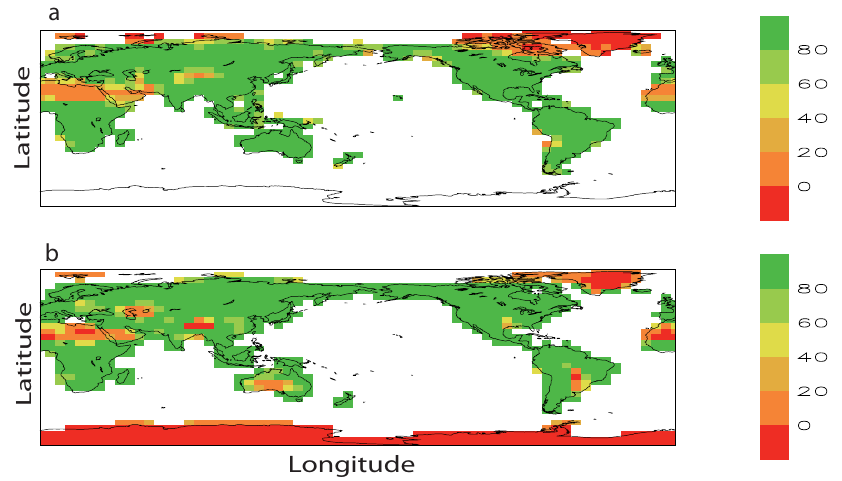
Fig. 14. Total vegetation cover in (a) GSWP2 dataset (International GEWEX Project Office, 2002) and in (b) LOVECLIM1.2 averaged over the period 1980–2000.